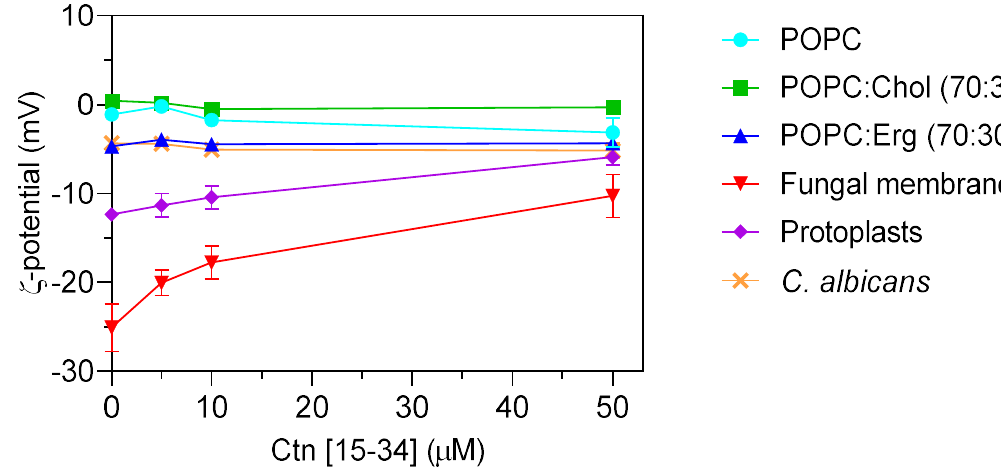
Figure 5. Zeta potential ( ζ ) of lipid vesicles, C. albicans protoplasts, and C. albicans cells. Lipid vesicles were tested at a total lipid concentration of 200 µ M. C. abicans cells and protoplasts were tested at the concentration of 10 5 cells mL − 1 . The results showed the importance of some membrane components of the cell membrane for Ctn[15–34] interaction. C. albicans and POPC:Erg vesicles show similar zeta potential behavior upon increasing Ctn[15–34] concentration. The initial values are − 12 mV for protoplasts and –25 mV for fungal membrane-like vesicles. Data are presented as mean ± SD of three independent replicates.